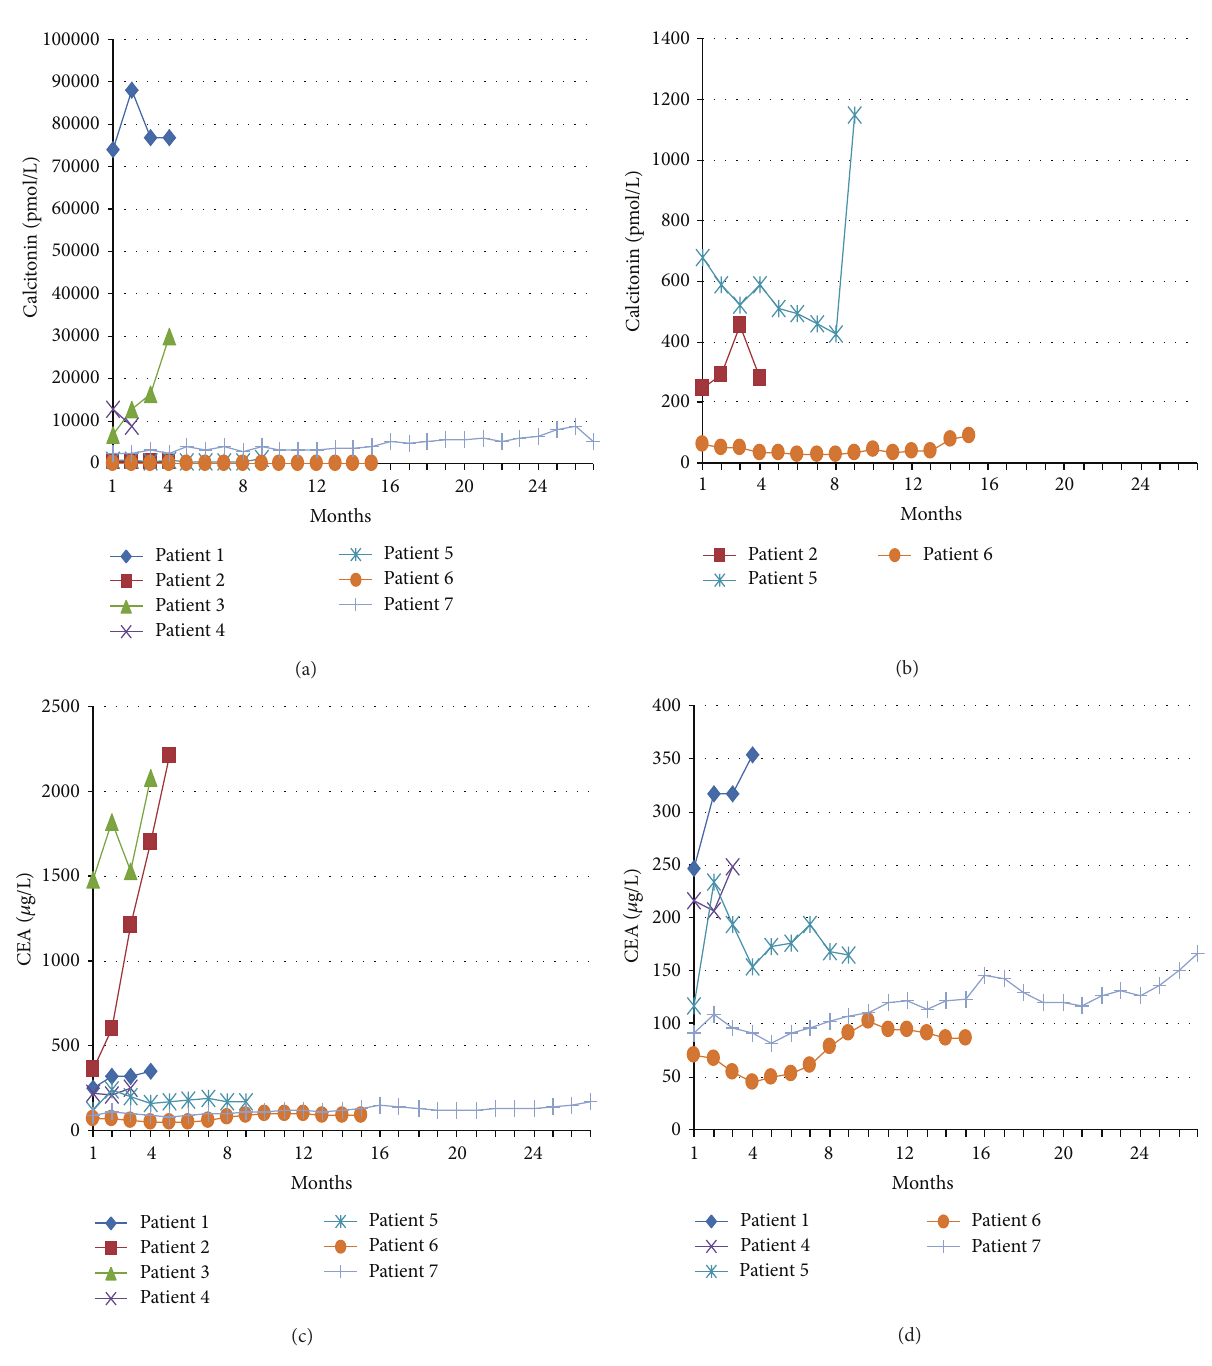
Figure 2: Serum calcitonin and CEA concentrations per patient over time. (a) Serum calcitonin over time for all patients, (b) close-up of figure (a) for patients 2, 5, and 6, (c) serum CEA for all patients, and (d) close-up of figure (c) for patients 1, 4, 5, 6, and 7.